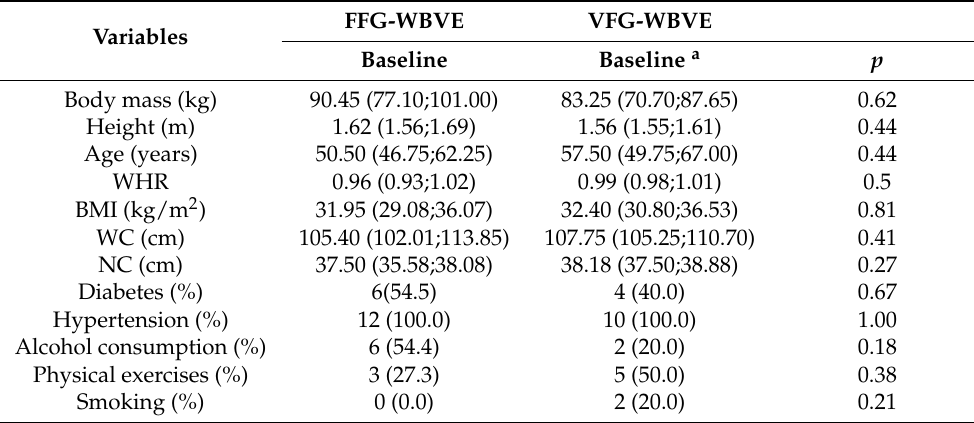
Table 1. Some anthropometrics characteristics and prevalence of concomitant diseases and lifestyle of groups (FFG-WBVE vs.